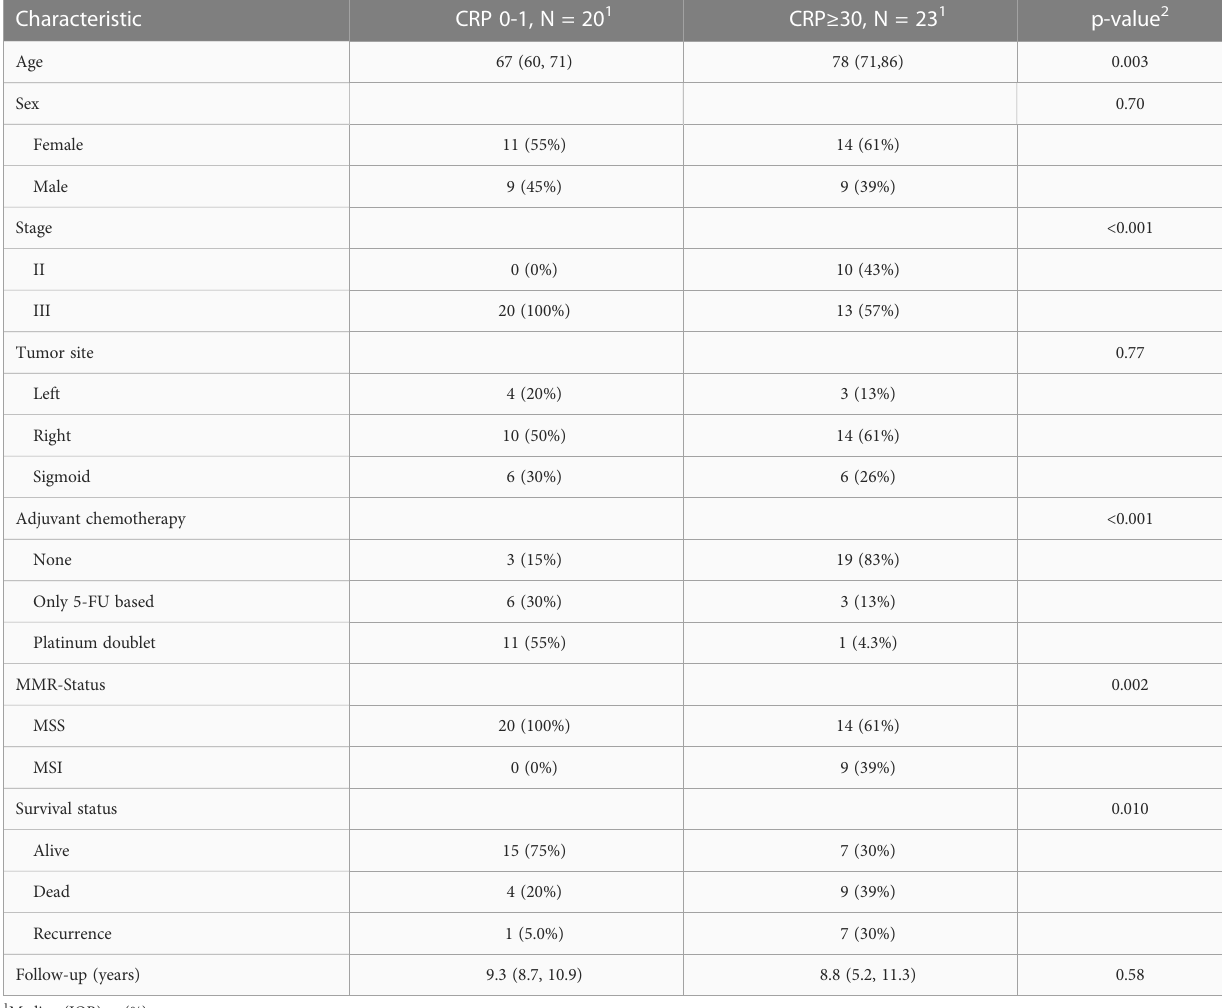
TABLE 1 Clinical characteristics of colon cancer patients according to the level of circulating CRP.